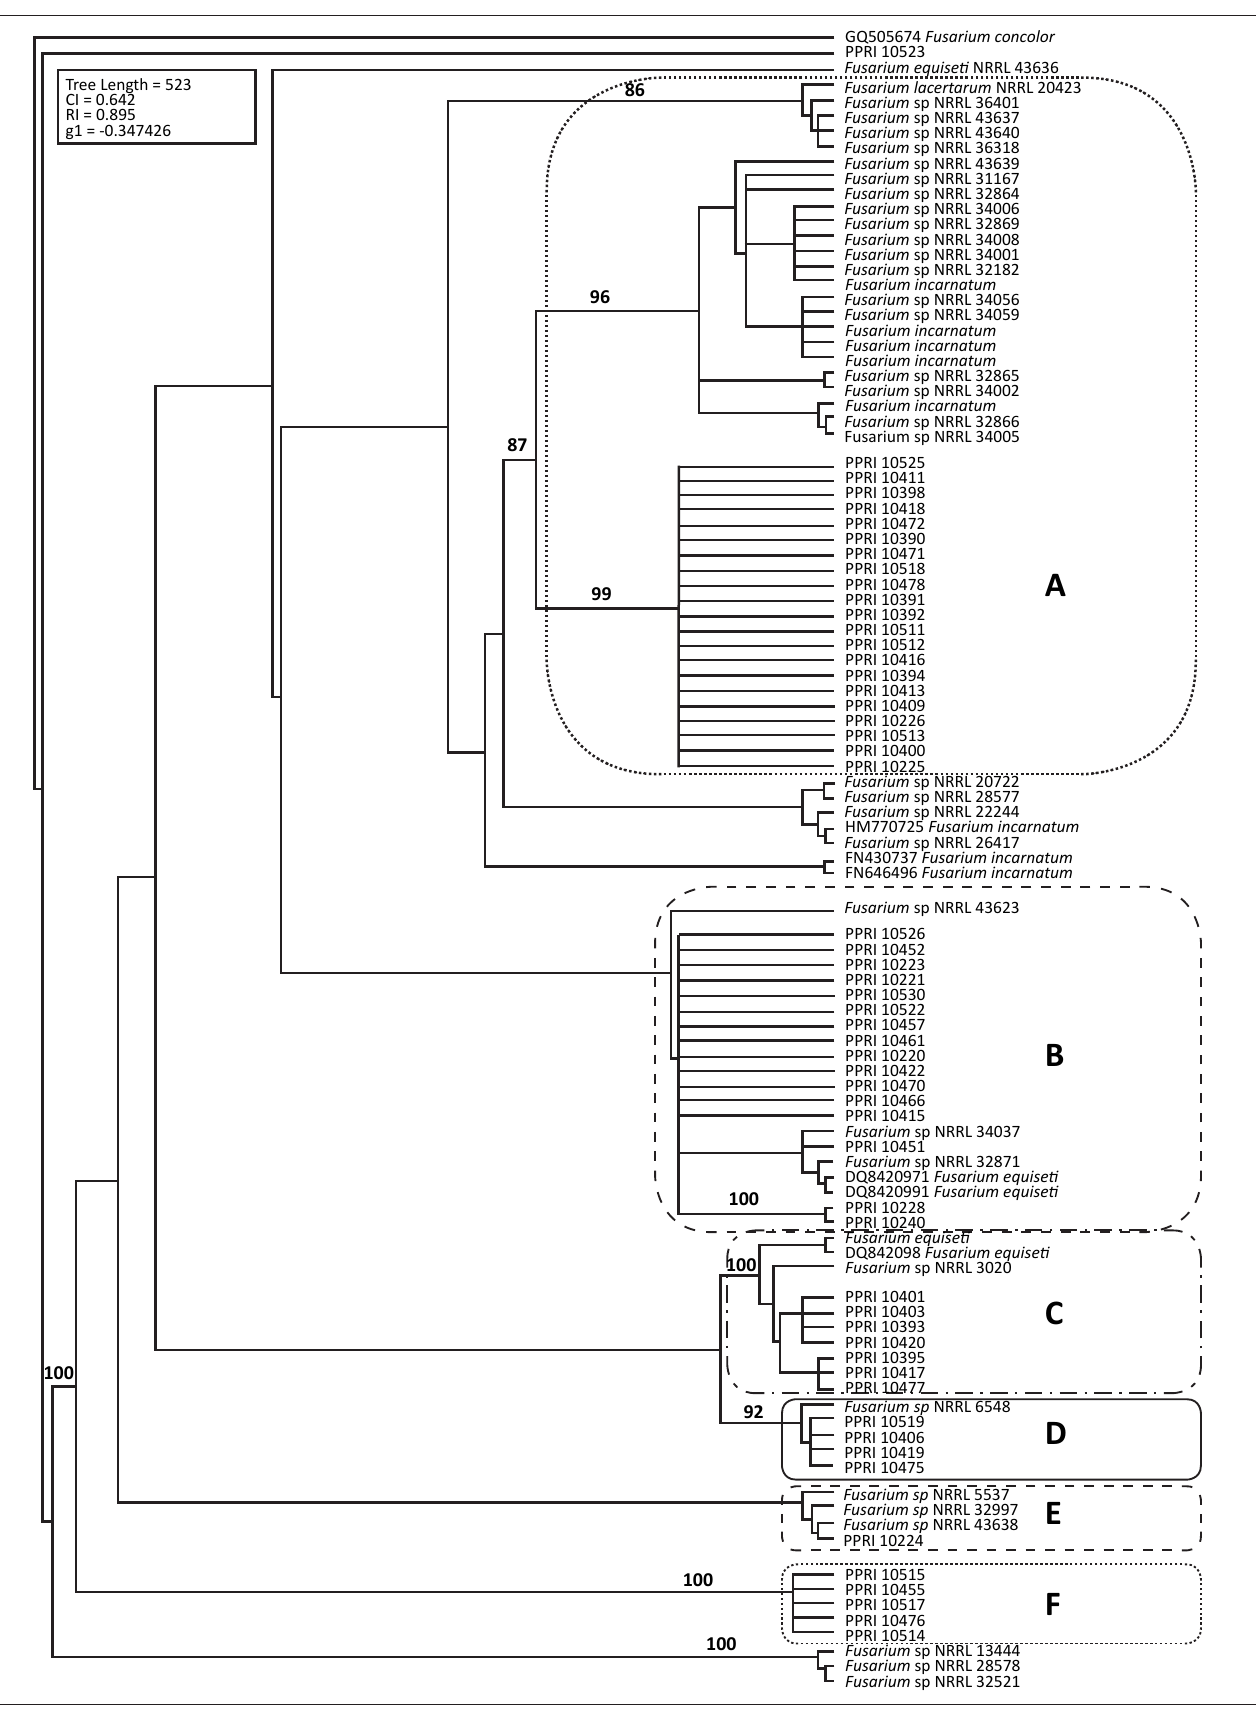
FIGURE 1: Phylogenetic tree produced using parsimony of the translation elongation factor gene with Fusarium concolor as